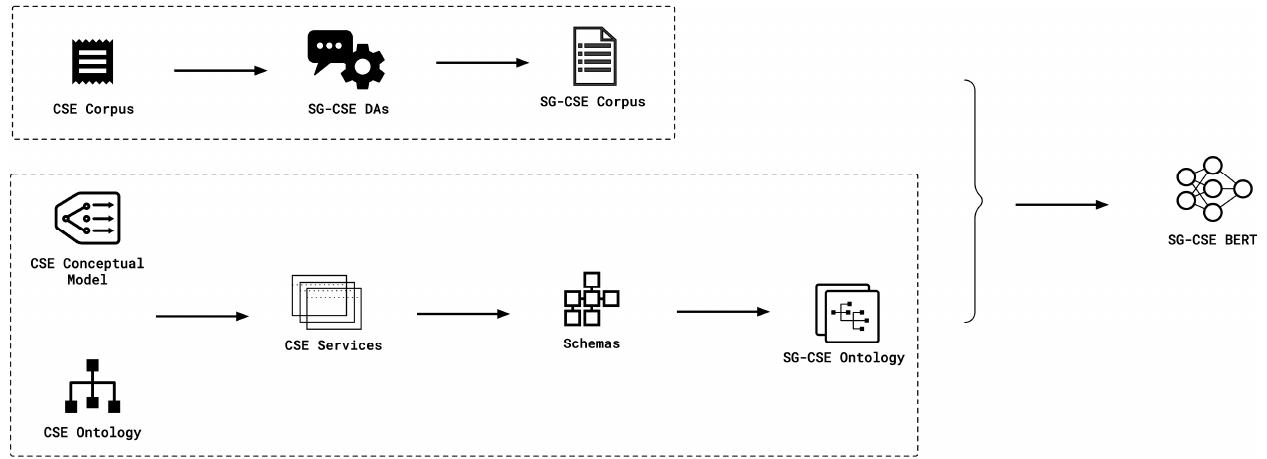
Figure 2. Implementing SG-CSE BERT.